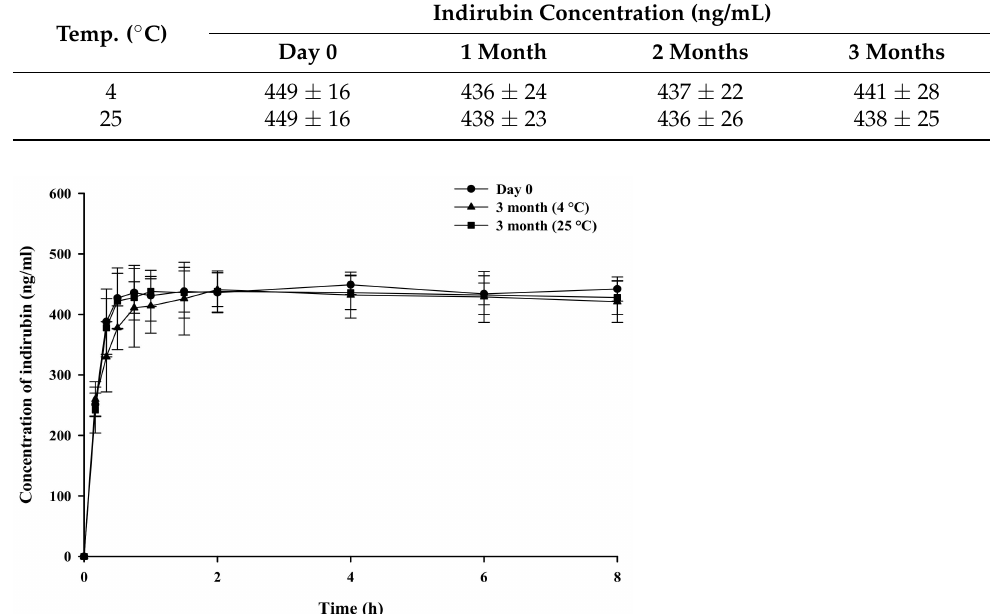
Figure 8. Dissolution profiles of indirubin from SD-F4 (mean ± s.d., n = 3). After three months of storage at 4 ◦ C and 25 ◦ C, the dissolution profiles of SD-F4 were evaluated in water and compared to those on Day